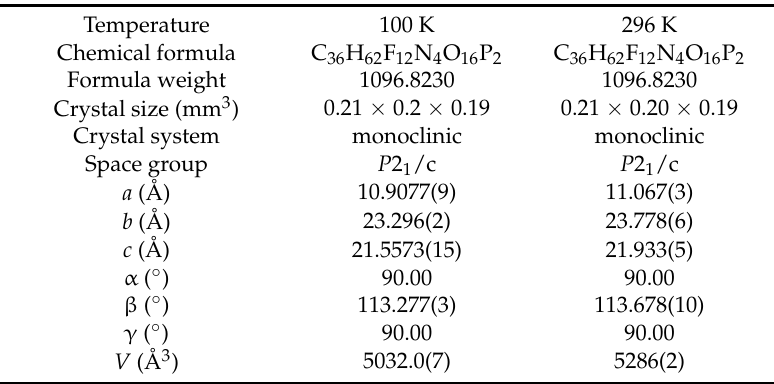
Table 1. Crystallographic data for compound 1 .